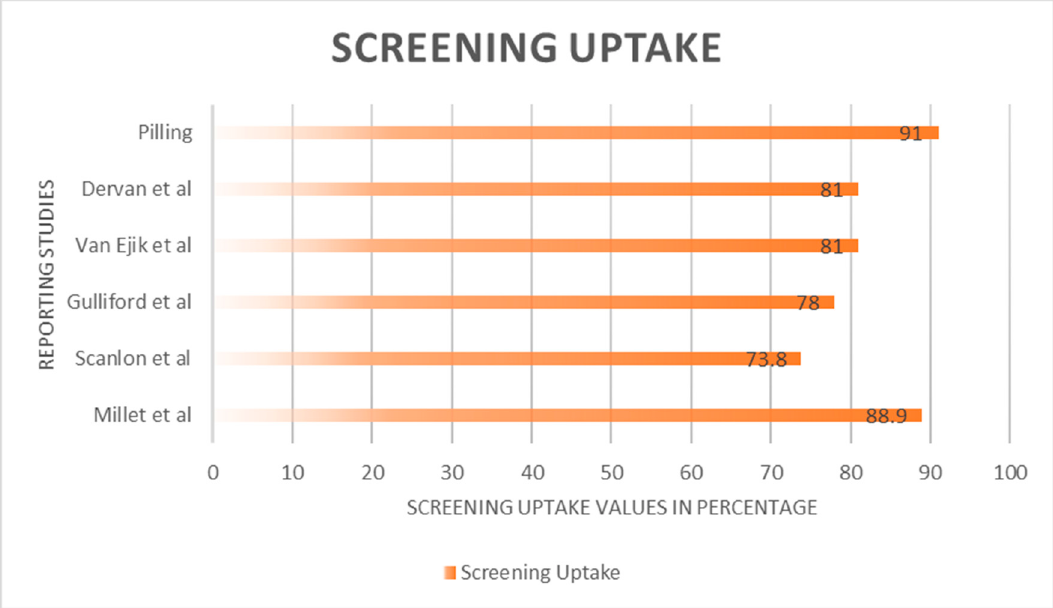
Figure A2. Reported screening uptake.